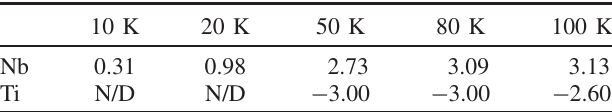
niobium and titanium, taken from [11]. Values are given in μ V = K.